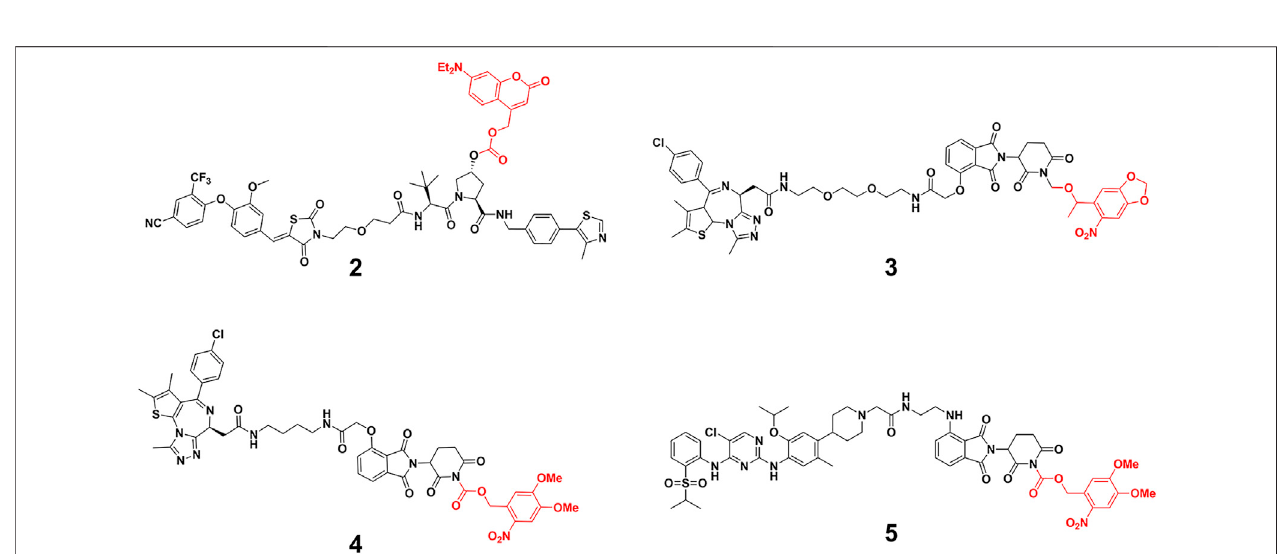
FIGURE 2 | Chemical structure of caging